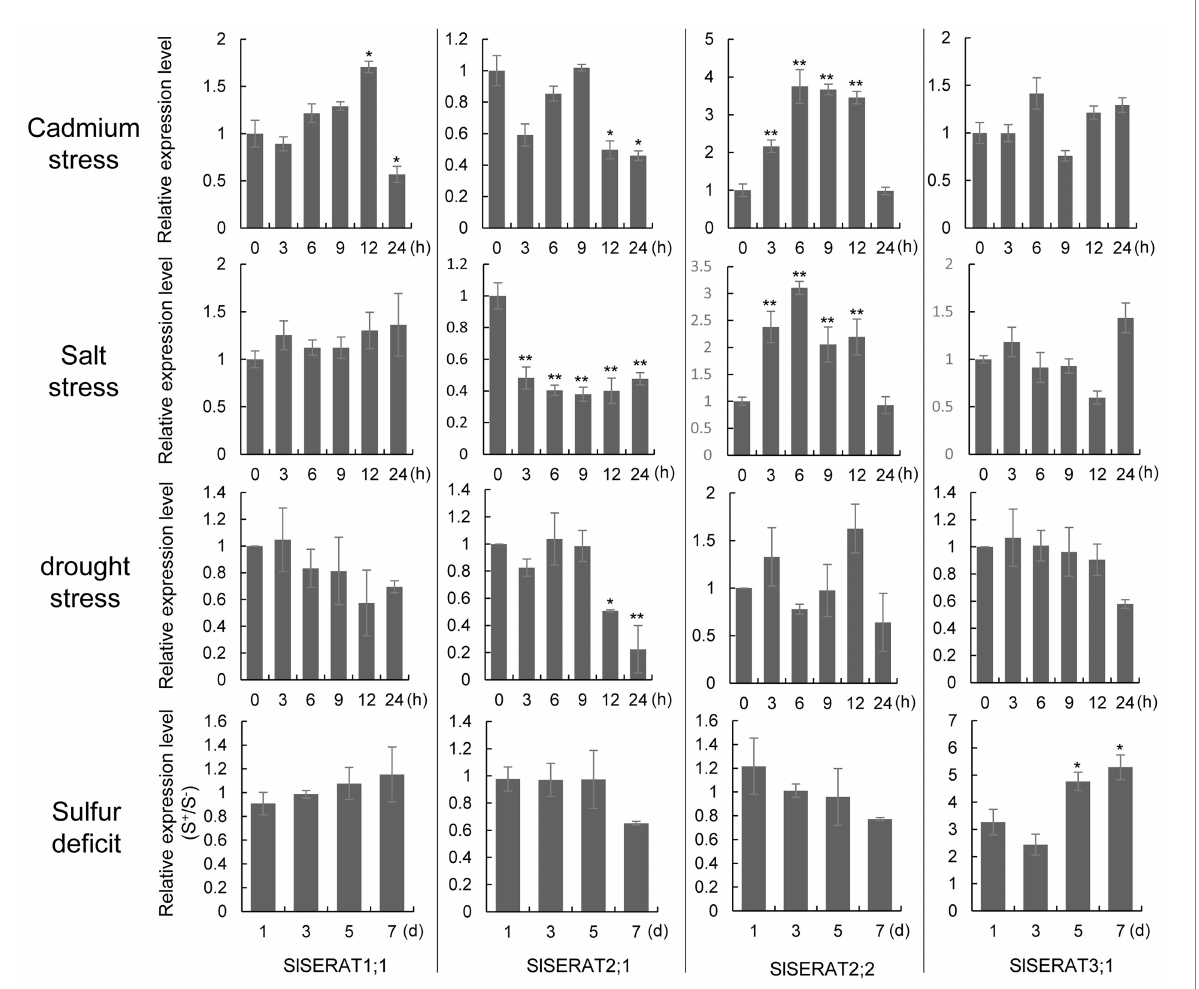
FIGURE 6 Expression level changes of the SlSERAT genes under different stresses. The tomato ACTIN gene was used as the internal control. For cadmium, salt and drought stresses, the relative expression levels were fold-change values compared with the untreated materials (0 h). For the sulfur-deficit assay, the relative expression levels were fold-change values compared with the samples grown on +S medium at every detection time point. * p < 0.05 and ** p < 0.01 indicate statistically significant